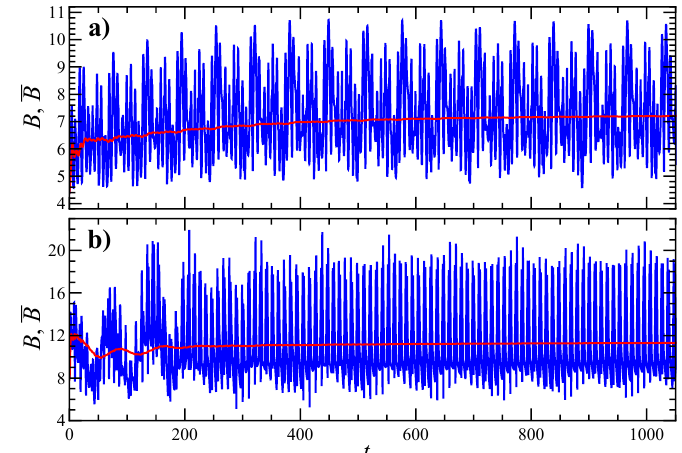
Figure 6. ( a ) Time evolution of intrinsic viscosity B (blue curve) and time-average intrinsic viscosity B (red curve) for the trajectory reported in Figure 4. ( b ) The same as a for the trajectory in Figure